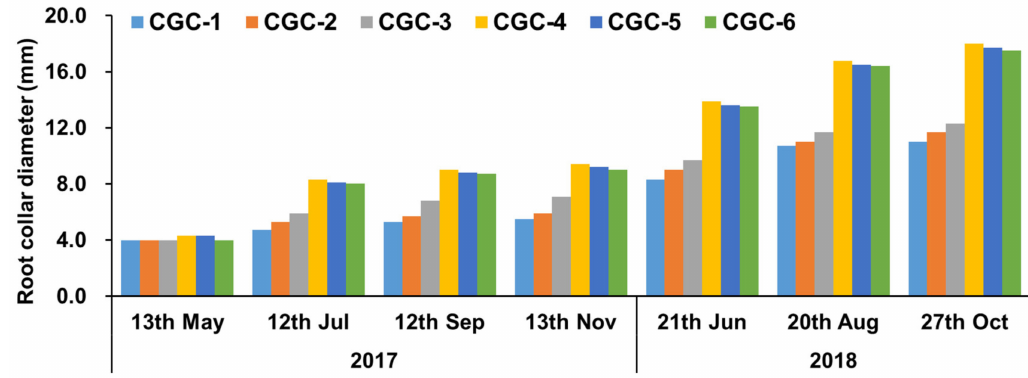
Figure 3. Pinus densiflora seedling root collar diameters (mm) affected by different container growth conditions (CGCs). CGC-1: Control container without modification; CGC-2: CGC-1 with inside 5 mm thick root-turning bump; CGC-3: CGC-1 with inside 10 mm thick root-turning bump; CGC-4: negative phototropism container with a vertical striped slit made on the surface of CGC-1;